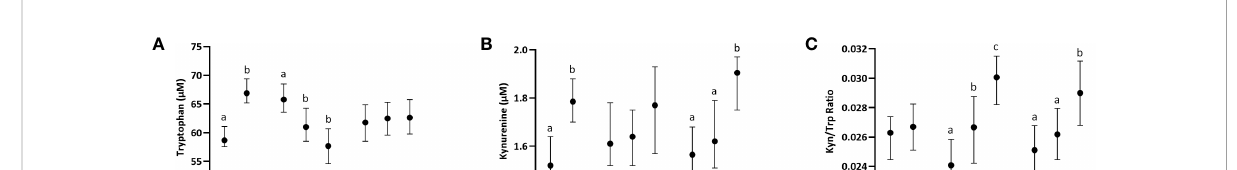
for multiple comparisons (Figure 3; Table S3B). Activated effector memory CD8 T-cells with CD38 activation marker (Figure 3A; Table S3B) and percentage of intermediate monocytes (Figure 3E; Table S3B) were positively associated with Kyn/Trp. Also, CRP, SAA, ICAM-1, VCAM-1, TNF- a , IL- 10, the chemokines IL-8, IP-10, MCP-1, eotaxin, and MDC and the markers of macrophage activation neopterin and sCD14 were all positively associated with Kyn/Trp (Figure 3F;